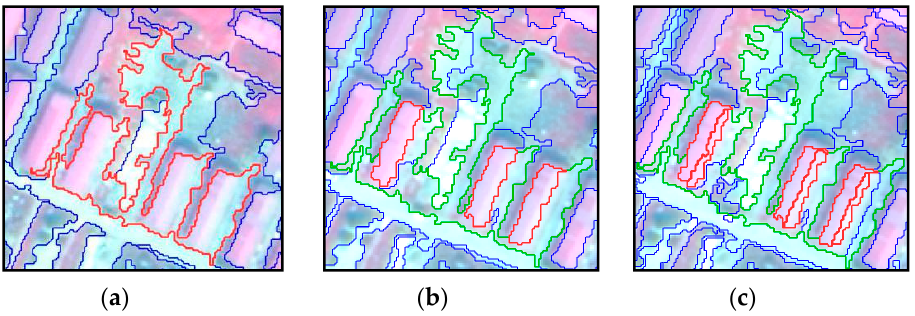
Figure 4. The segmentation effect at different scales. ( a ) Shape 0.2, compactness 0.5, and segmentation scale 126; ( b ) shape 0.2, compactness 0.5, and segmentation scale 86; and ( c ) shape 0.2, compactness 0.5, and segmentation scale 53.